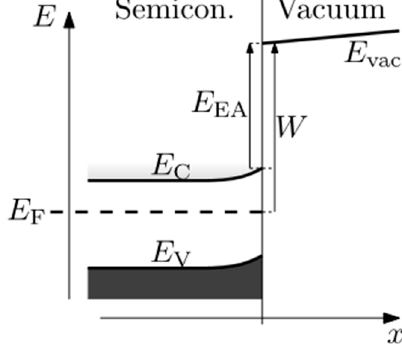
Figure 3. Band diagram of semiconductor-vacuum interface [13] showing electron affinity E EA , defined as the difference between near-surface vacuum energy E vac , and near-surface conduction band edge E C . Fermi level E F , valence band edge E V , work function W .